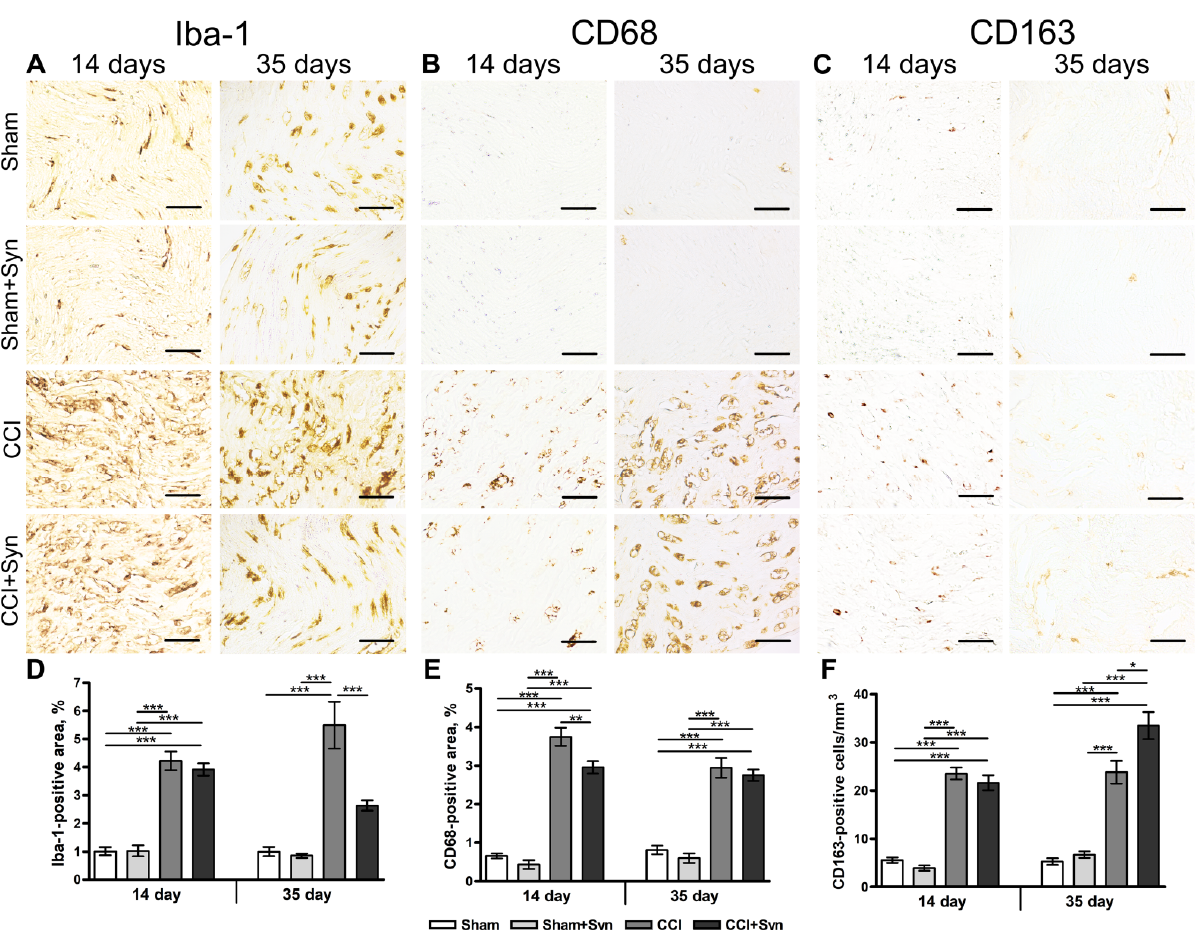
Figure 3. Inflammation in the distal segment of the sciatic nerve. Representative images of ( A ) ionized calcium-binding adapter molecule 1- (iba-1-), ( B ) CD68- and ( C ) CD163-positive staining. Scale bar is 50 µ m. ( D ) The staining area (% of total area of the nerve) of iba-1-positive macrophages within the distal segment of the sciatic nerve, mean ± SEM, n = 7 (number of animals/group) *** p < 0.001 (one-way ANOVA, post-test Tukey). ( E ) The staining area (% of total area of the nerve) of CD68- positive macrophages within the distal segment of the sciatic nerve, mean ± SEM, n = 7 (number of animals/group) ** p < 0.01, *** p < 0.001 (one-way ANOVA, post-test Tukey). ( F ) The staining area (% of total area of the nerve) of CD163-positive macrophages within the distal segment of the sciatic nerve, mean ± SEM, n = 7 (number of animals/group) * p < 0.05, *** p < 0.001 (one-way ANOVA,